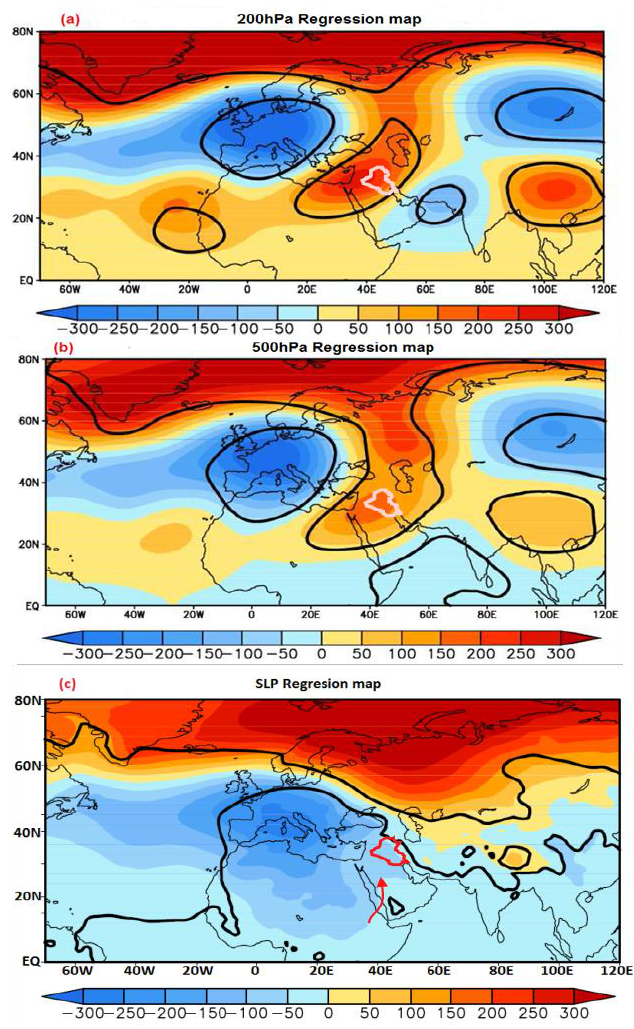
Figure 3. Regression maps of winter ( a ) geopotential height 200 hPa, ( b ) 500 hPa and ( c ) SLP fields on the time series of North Atlantic SLP associated to the first pair derived through CCA (Figure 2b), for the 1979 – 2016 period. The red contour lines in panels ( a – c ) mark the border of Iraq. The thick red arrow in panel ( c ) is used to explain the air advection. The black contour lines in panels ( a – c ) represent the 95% confidence level of the statistical significance of the regression.